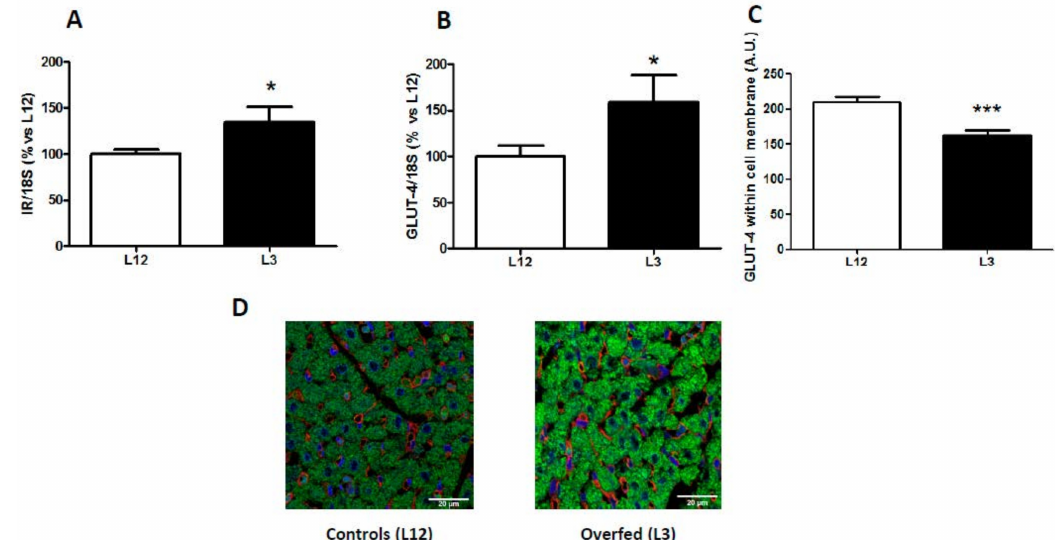
Figure 1. Gene expression of ( A ) insulin receptor (IR) and ( B ) glucose transporter 4 (GLUT-4), and GLUT-4 localization ( C , D ) in hearts from rats raised in L12 or L3 litters. Note: * p < 0.05 di ff erence between L3 and L12; *** p < 0.001 di ff erence between L3 and L12. Values are represented as mean ± SEM ( n = 4–5 rats / experimental group) and expressed as % vs. L12. All samples were run in duplicate. Data were analyzed by Student’s t -test. Scale bar in D denotes 20 µ m.